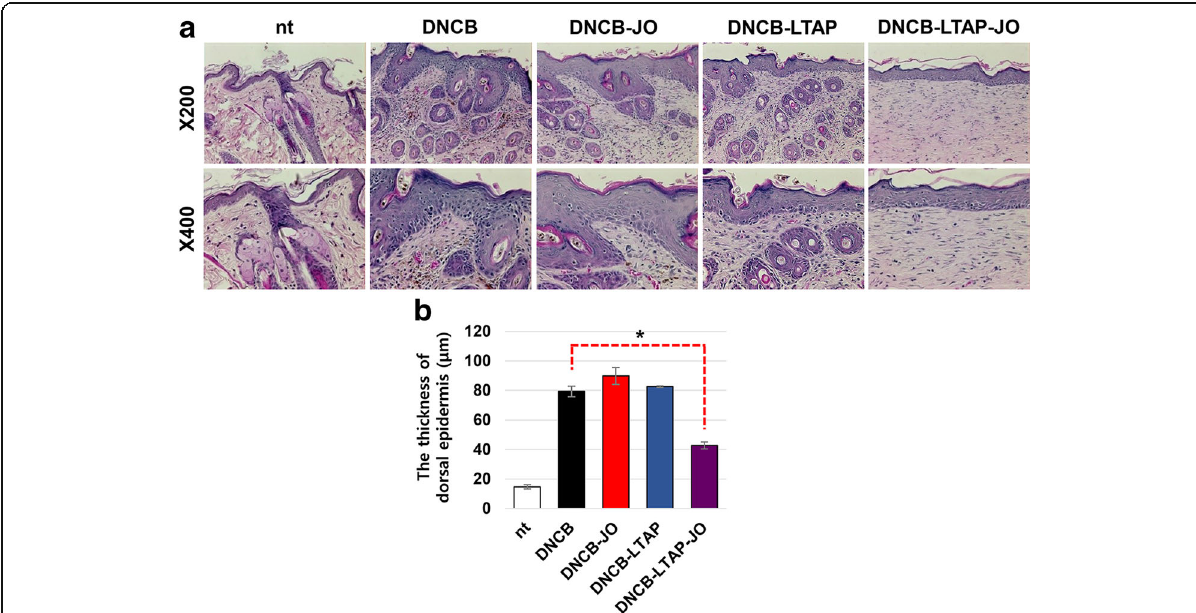
Fig. 3 The effects of LTAP-JO treatment on DNCB-induced changes in the dorsal skin tissue. a The results of H&E staining using dorsal skin tissues isolated from the mice of each group at the end of the experiments. Data shown are the representatives of each group of mice. b The epidermal thickness of the dorsal skin was measured using an image analysis system as described in 2. Materials and Methods. Data represents the mean ± SEM ( n = 50). The significance of the difference ( p < 0.05) is described